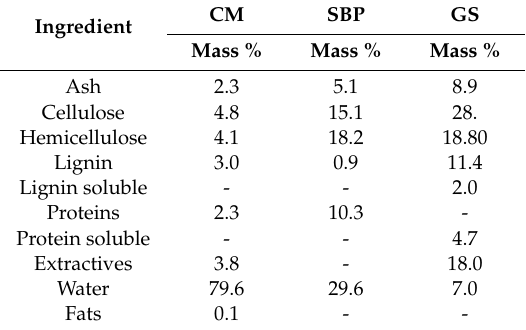
Table 1. Composition of CM, SBP and GS based on wet weight